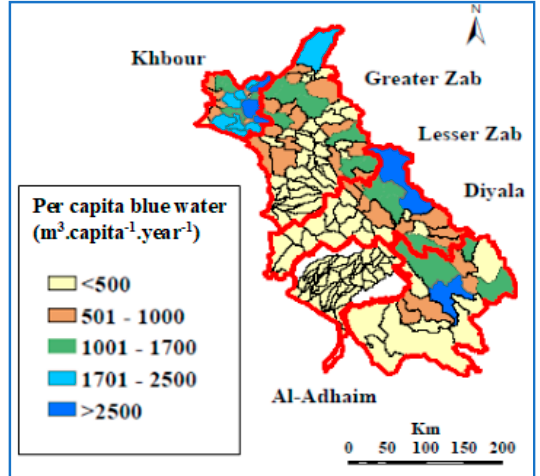
Figure 5. Water scarcity in northeast Iraq from 1980–2010 average annual blue water flow availability per capita per year using population of 2005.